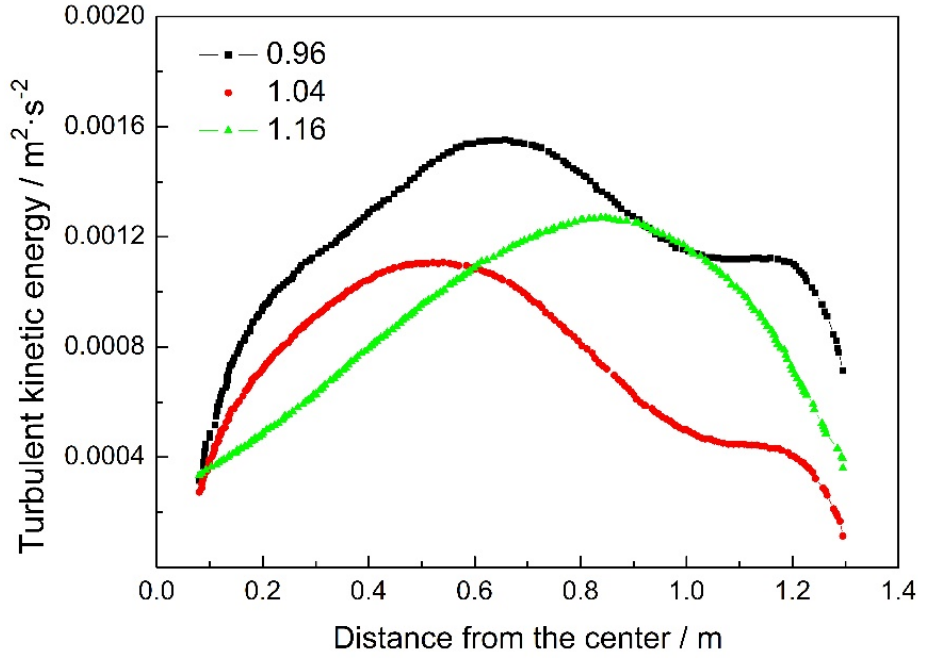
Figure 7. Influence of the area ratios of the turbulent kinetic energy at free surface.